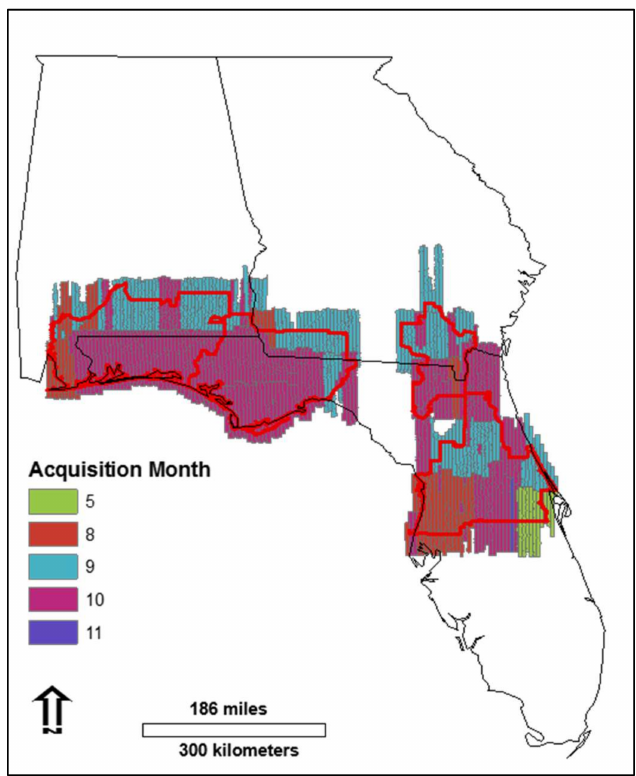
Figure 2. Acquisition month for National Agricultural Imagery Program (NAIP) flight lines within the extent of the Significant Geographic Areas